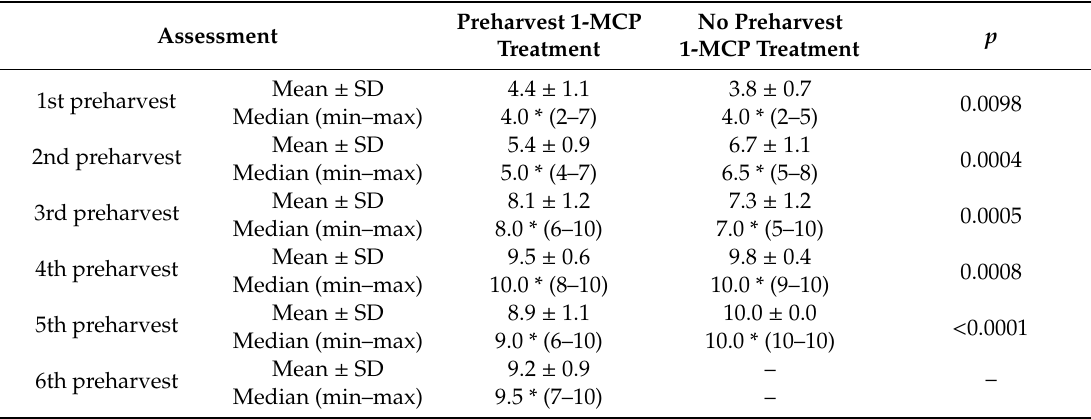
Table 5. Results for starch index measured in ‘Szampion’ cultivar apples in the preharvest period, compared for the group treated with 1-MCP and a control group not treated with